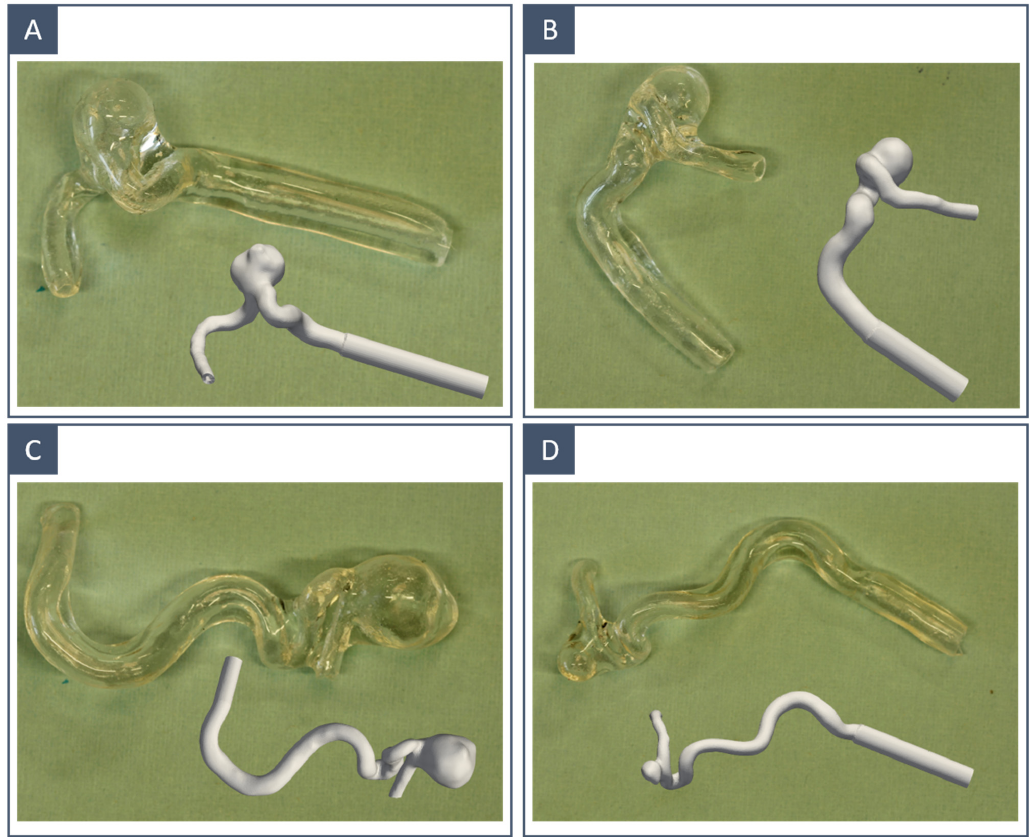
Figure 7. Patient-specific phantoms with the corresponding 3D surface model. The surface models were selected from those available in the free AneuriskWeb dataset repository. Models ( A , B ) were obtained with an FDM-printed inner mould; models ( C , D ) were obtained with an SLA-printed inner mould.